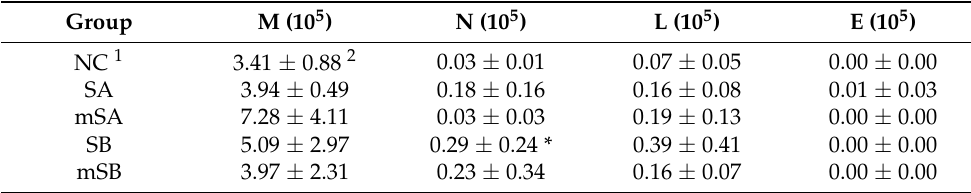
Table 13. Changes of bronchoalveolar lavage fluid, WBC total count, and WBC differential count of rats after intratracheal instillation with unmodified and modified nano-silica on Day 14.